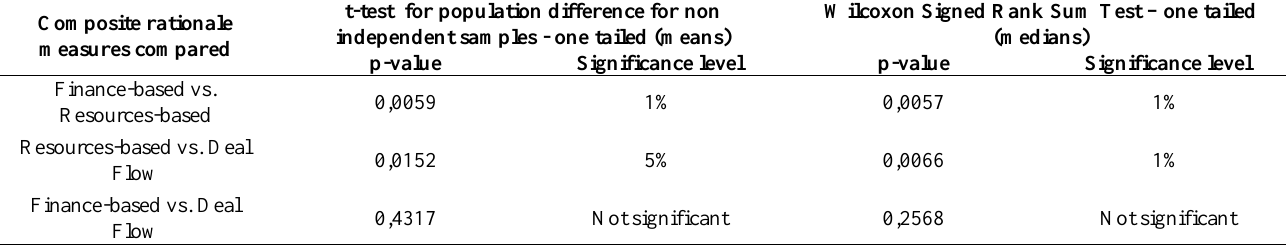
Table 3: Pair-wise tests for differences in the means and medians of the composite rationale variables t-test for population difference for non